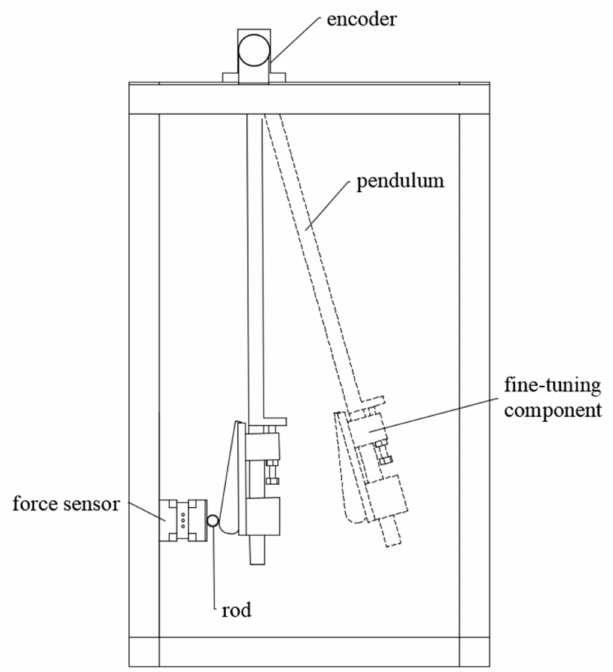
Figure 7. The pendulum